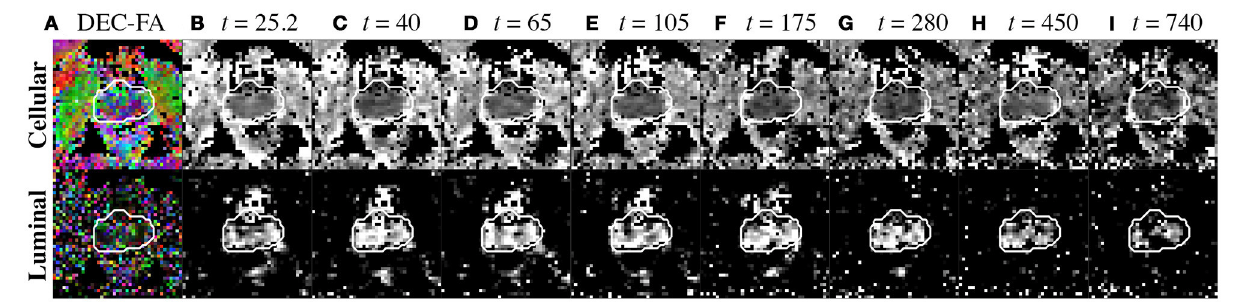
FIGURE 8 | Compartment parameters derived from the diffusion tensor. (A) Cellular and luminal directionally-encoded color FA (DEC-FA) were derived from principle eigenvalues of the mean dyadic tensor over time and the median FA(t). (B–I) Mean diffusion over diffusion time, D ( t ), is shown for both cellular and luminal compartments. The whole prostate ROI was drawn from the image at t 25.2ms and overlaid onto all parameter maps with a white outline to highlight any =